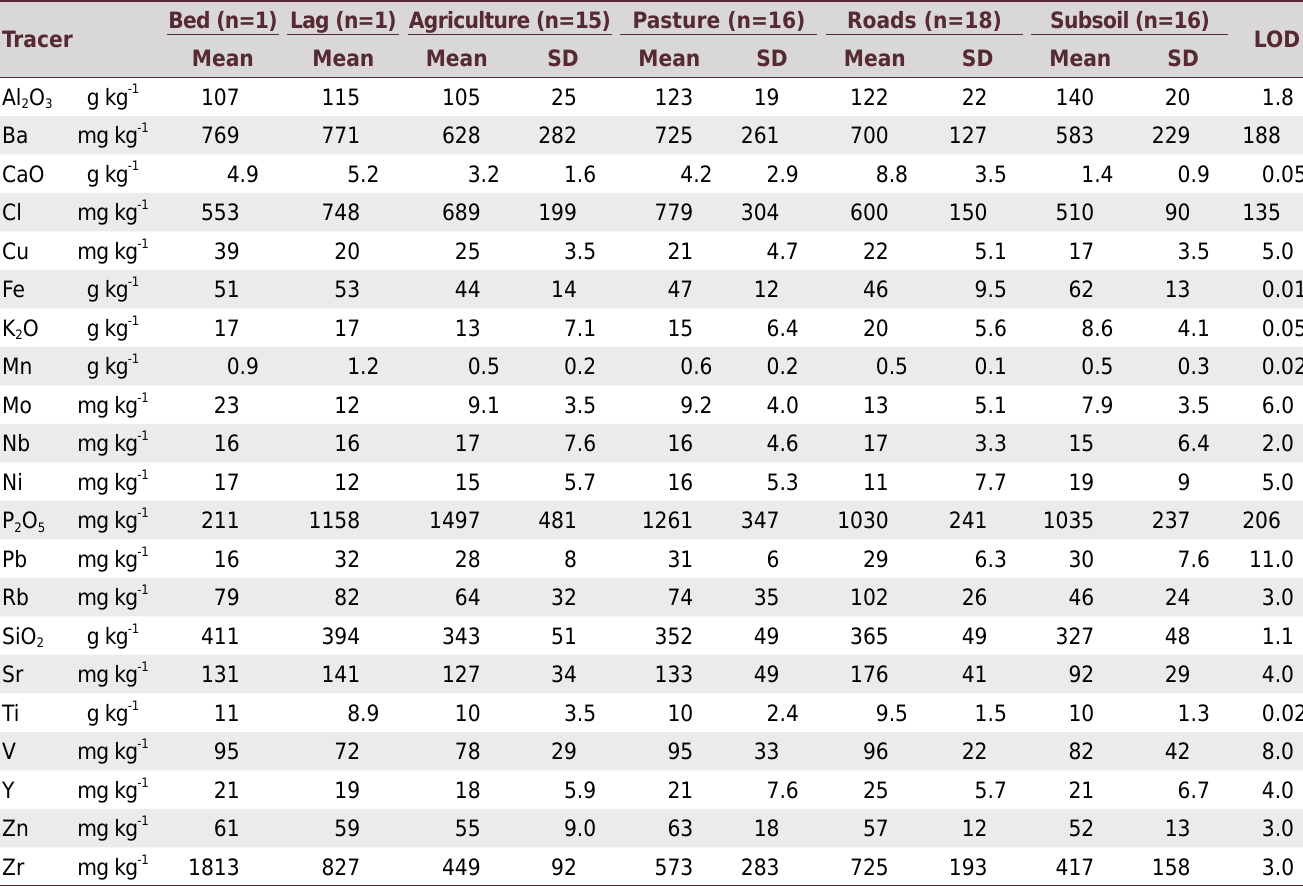
Table 1. Mean and standard deviation (SD) of the concentrations of geochemical tracers analyzed in sediment samples (Bed – river bed sediments; Lag – lag deposits) and in their potential sources in the Posses catchment Tracer